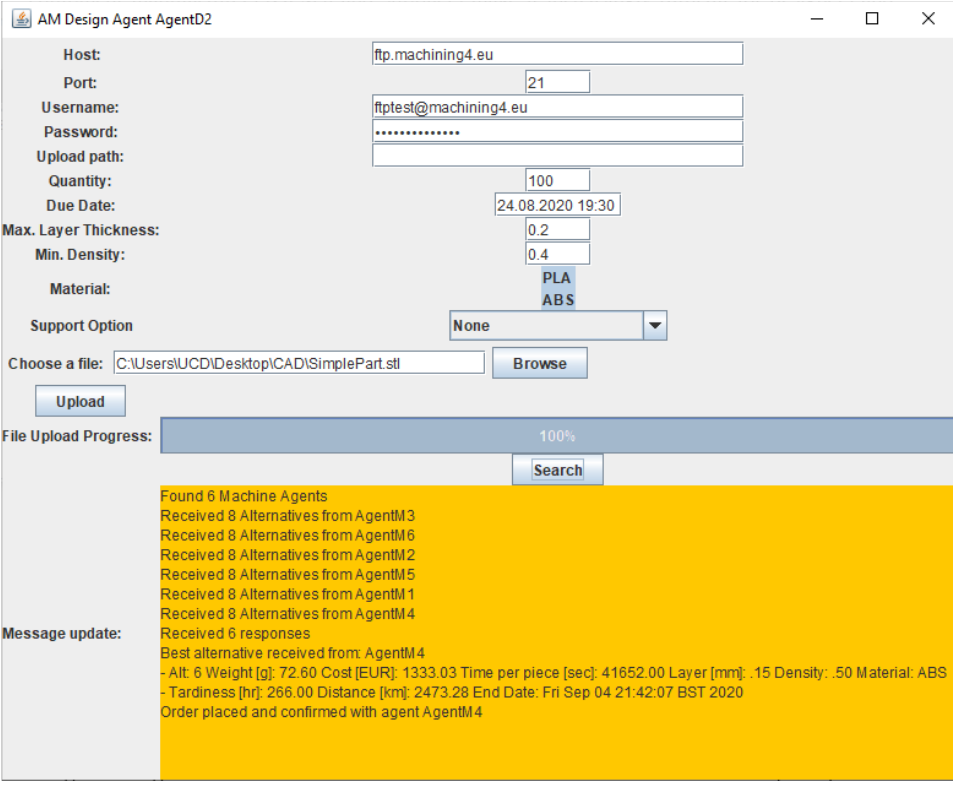
Figure 9. Test Case 1—Cost and tardiness of different configurations. For the test case 1, agent MA6 provided the least expensive configuration. However, due to its lower degree of availability, this alternative was not the one selected. MA4 provided the best- balanced configuration, exhibiting low cost and tardiness. The most expensive process configuration was provided by agent MA2, since the AM service provider the agent represents is the most expensive one and this particular configuration is related to the lowest possible layer thickness and the highest infill density, leading also to very high tardiness.